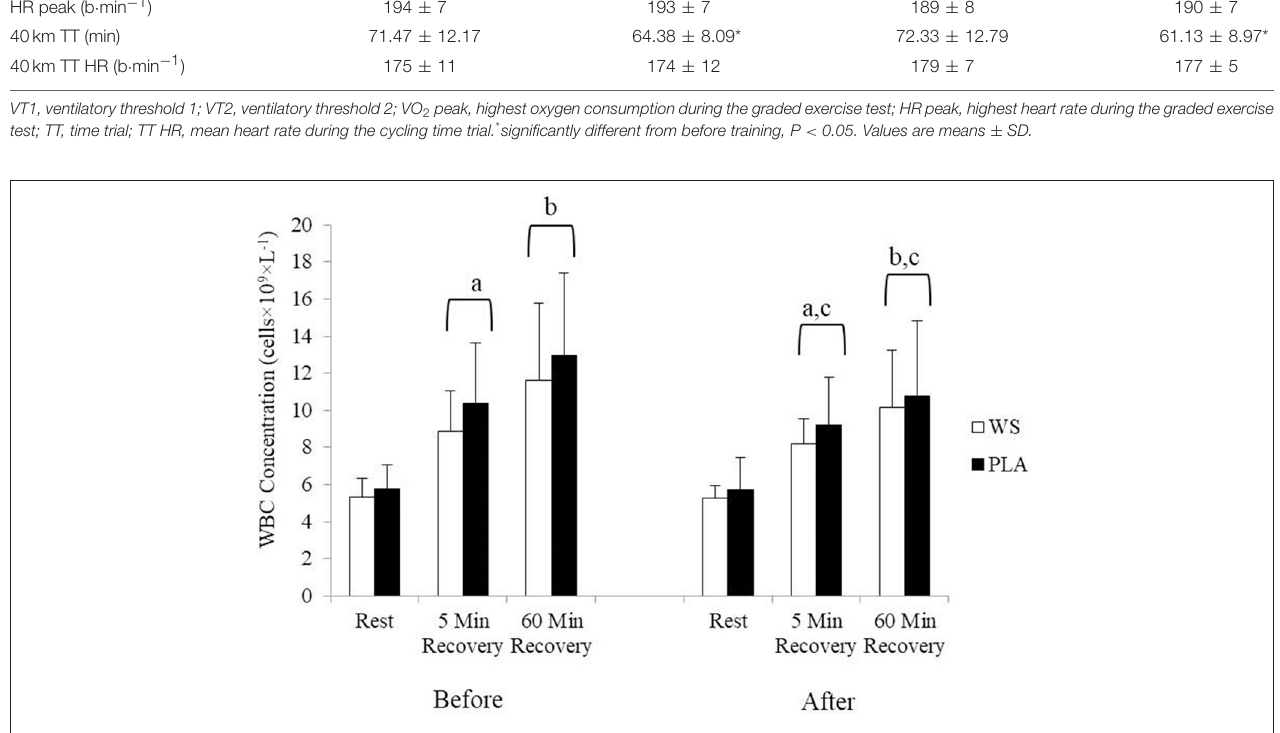
FIGURE 1 | White blood cell concentration at rest, 5 and 60min after exercise before and after training for the whey supplement (WS) and placebo (PLA) groups. Values are means ± SD. a, significantly different from rest, P < 0.05; b, significantly different from rest and 5min after exercise, P < 0.05; c, significantly lower at 5 and 60min of recovery after training, P <